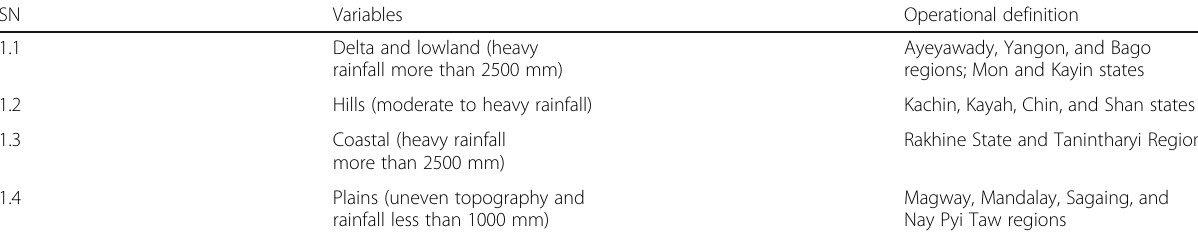
Table 2 Operational definitions ecological regions in Myanmar SN